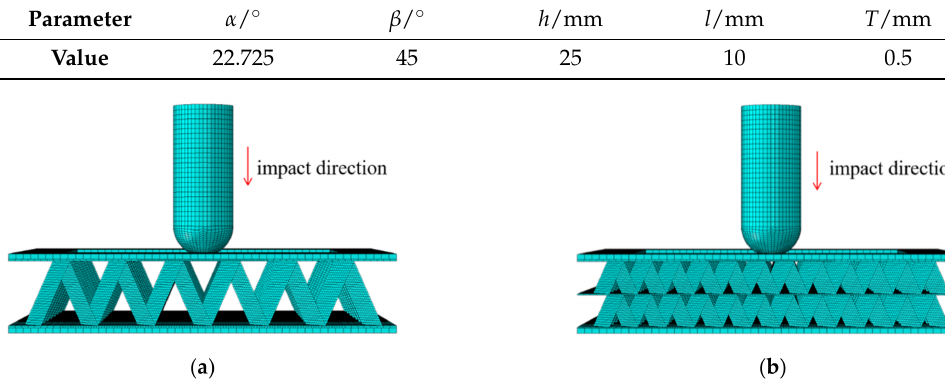
Figure 5. FE models of single − layer and double − layer folded sandwich structures. ( a ) single − layer model; ( b ) double − layer